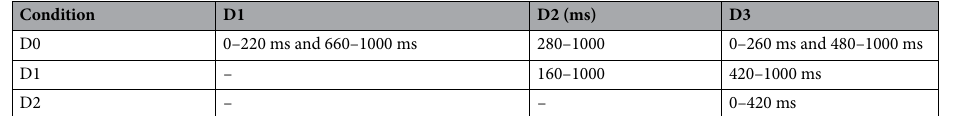
Table 1. Time intervals where a statistically significant difference was found between the time-course of theta power of the different delay conditions [ p < 0.05, randomization-based ANOVA test, FDR corrected].